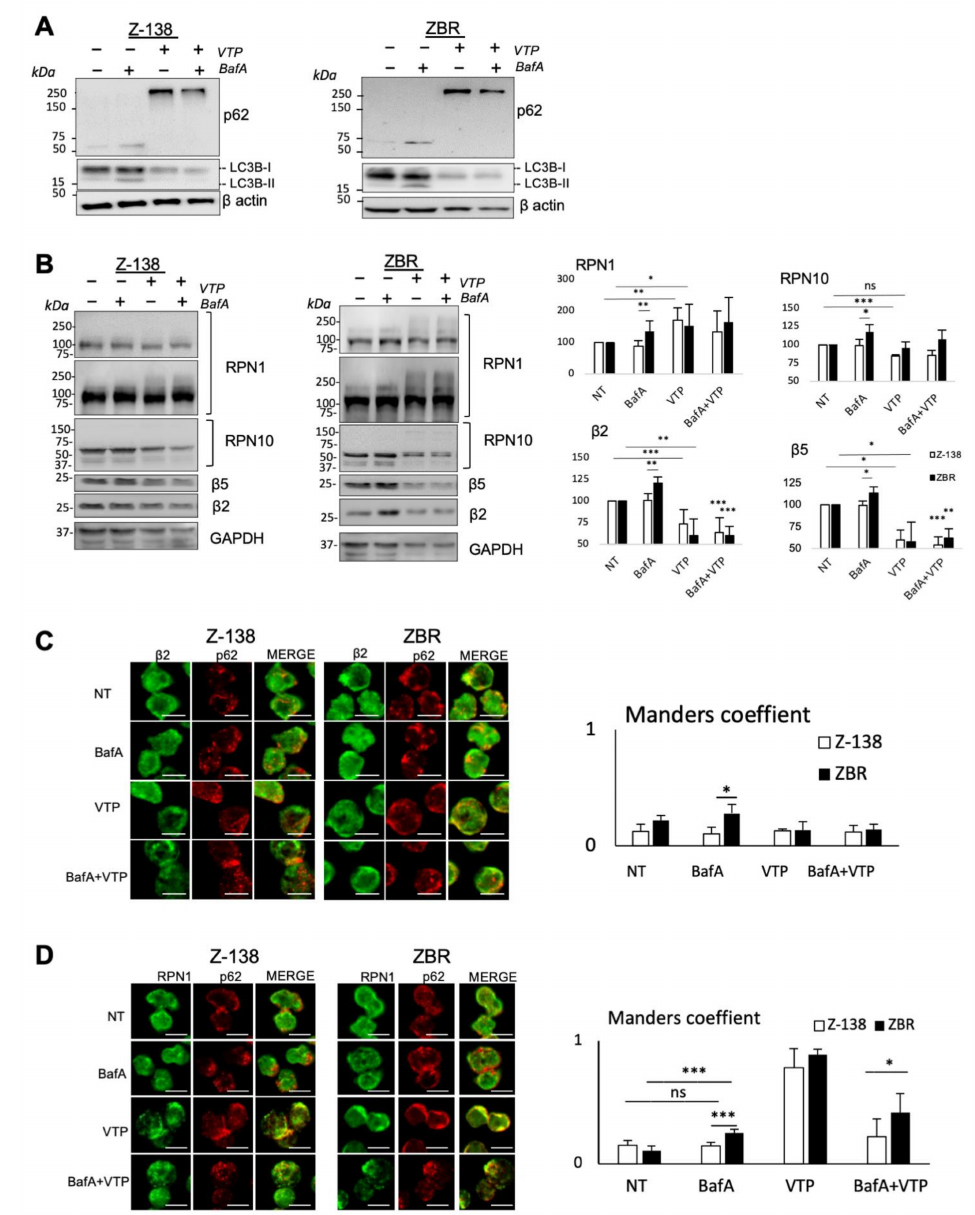
Figure 3. Inhibition of p62 affects the stability and localization of proteasome subunits. Z-138 and ZBR cells were treated with 40 nM BafA, 10 µ M VTP or with a combination of BafA/VTP at the same concentrations for 4 or 6 h, respectively. Whole-cell extracts were analyzed by WB to control autophagy flux ( A ) and the total expression of proteasome subunits after treatments ( B ). Relative protein levels were estimated and referred to GAPDH expression by densitometry, using the Image J software. Collected data from three independent experiments were presented in histograms (means ± SD). The two tailed t -test unambiguously confirmed the decrease of β 2 and β 5 subunits in ZBR relative to Z-138. ( C , D ) Co-localization of proteasome subunits with autophagosomes after treatment with autophagy inhibitors. Z-138/ZBR were treated or not treated for 4 h with 40 nM BafA or 10 µ M VTP or the combined treatment. Fixed cells were stained with anti- β 2 antibody (green) and p62 (red) ( C ), or with anti-RPN1 antibody (green) and anti-p62 (red) ( D ). Images were analyzed by confocal microscopy; scale bar indicates 10 µ m. Co-localization was measured with Mander’s correlation coefficient calculated in regions of interest containing LC3B or p62 punctates ( n ≥ 20; mean ± SD; two-tailed Student’s t -test, * p < 0.05, ** p < 0.01, *** p <